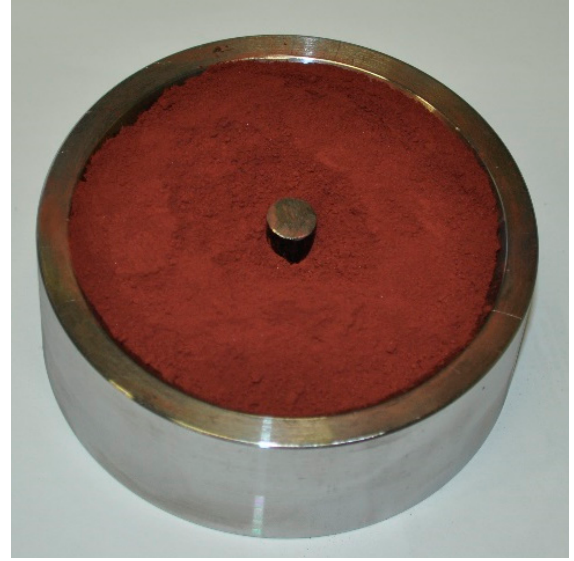
Figure 3. Steel crucible with iron ore.